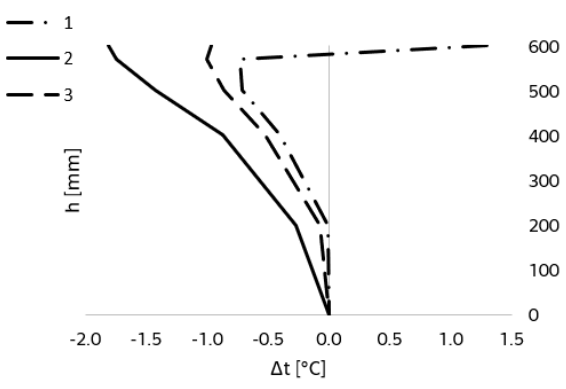
Figure 10. Measured temperature profiles in three spots in the abutment shaft (1 ⇒ 1 m from the edge of abutment; 2 ⇒ 4 m from the edge; 3 ⇒ in the middle of the